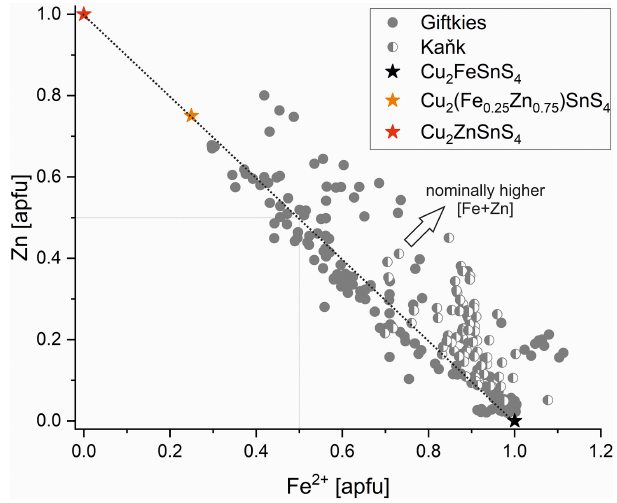
Figure 3. Calculated Fe 2 + and Zn (apfu) based on 4 S atoms of the stannite–kësterite series from Giftkies and Kaˇnk and nominal compositions of the